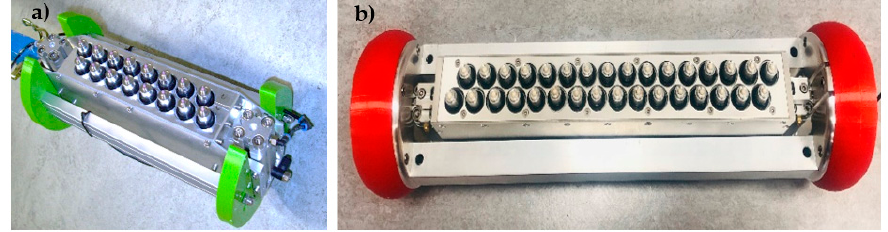
Figure 3. ( a ) Second generation borehole probe, ( b ) novel third generation borehole probe.